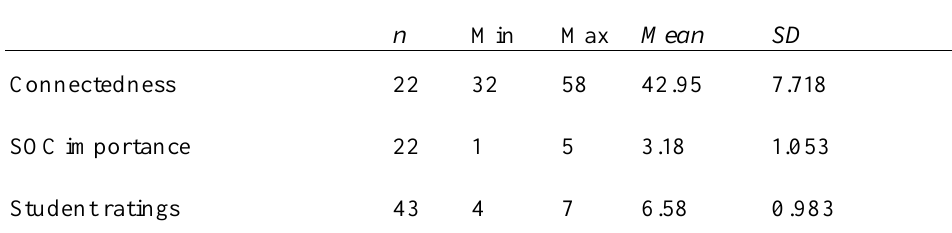
Descriptive Statistics for Iteration